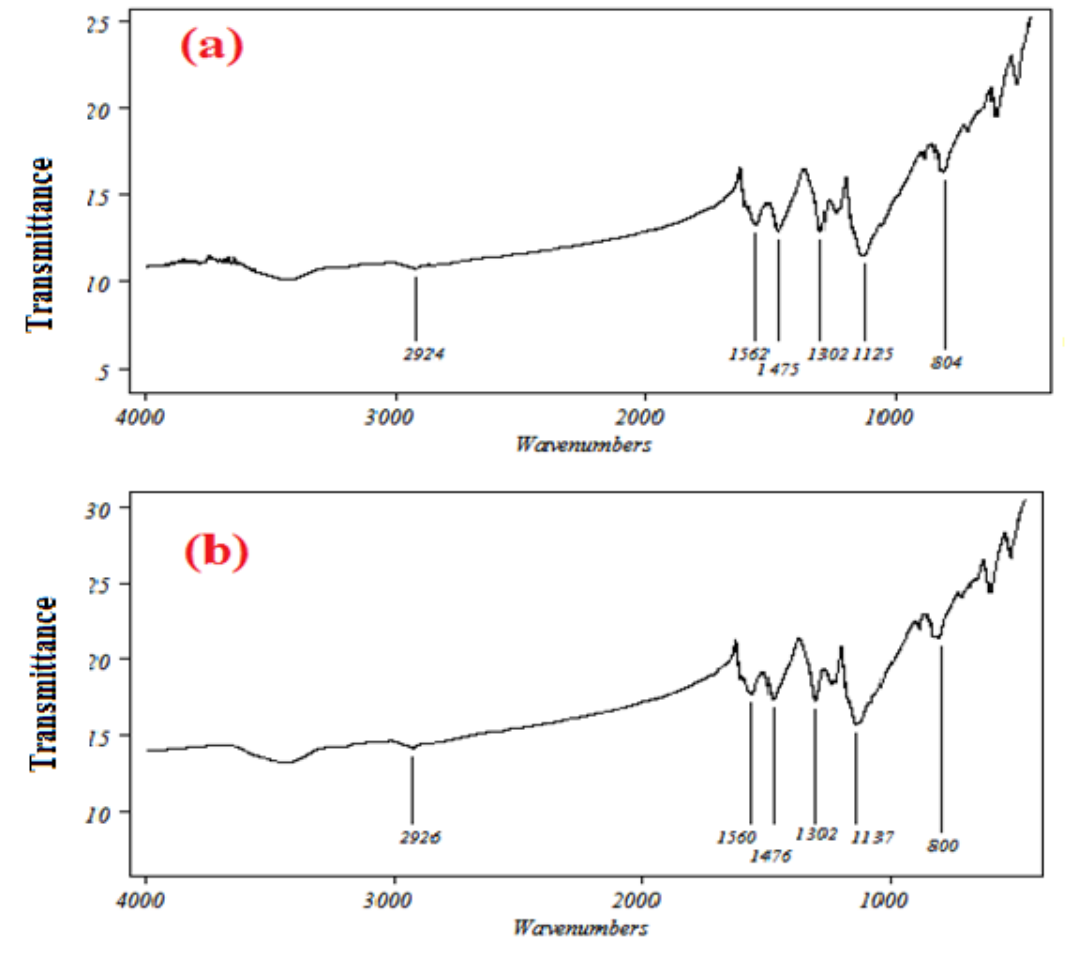
Fig. 4. FTIR spectra of (a) pure PAn, (b) PVP used as